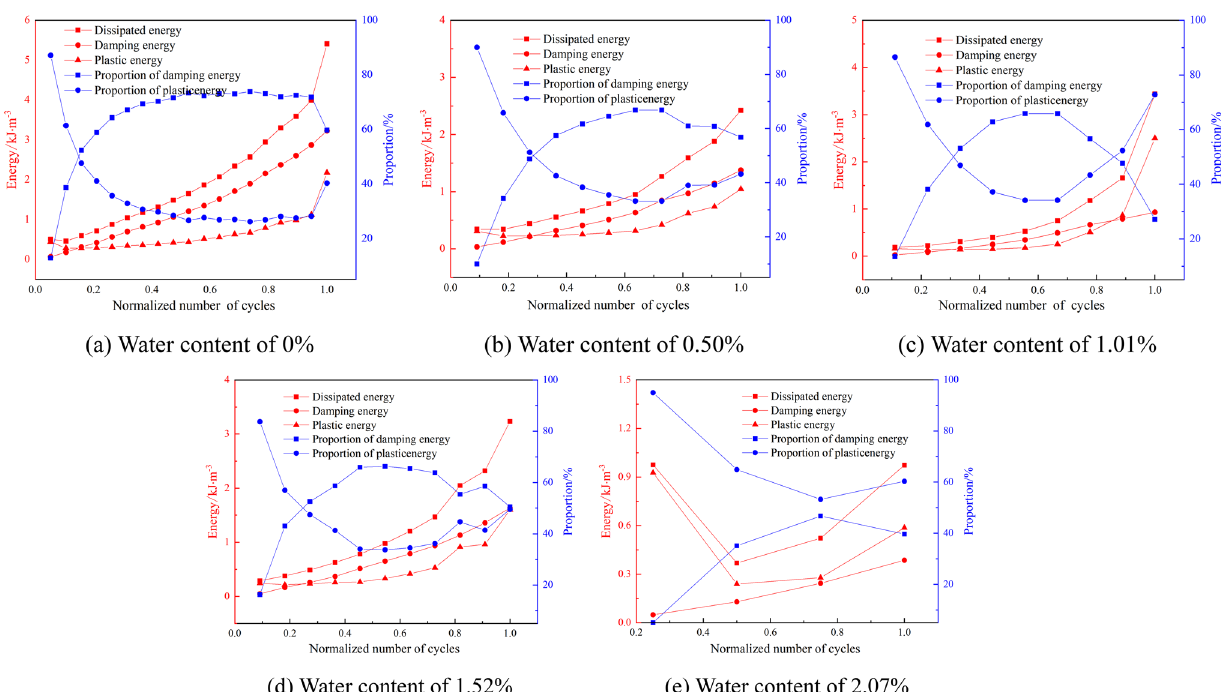
Fig. 11 Dissipated energy distribution